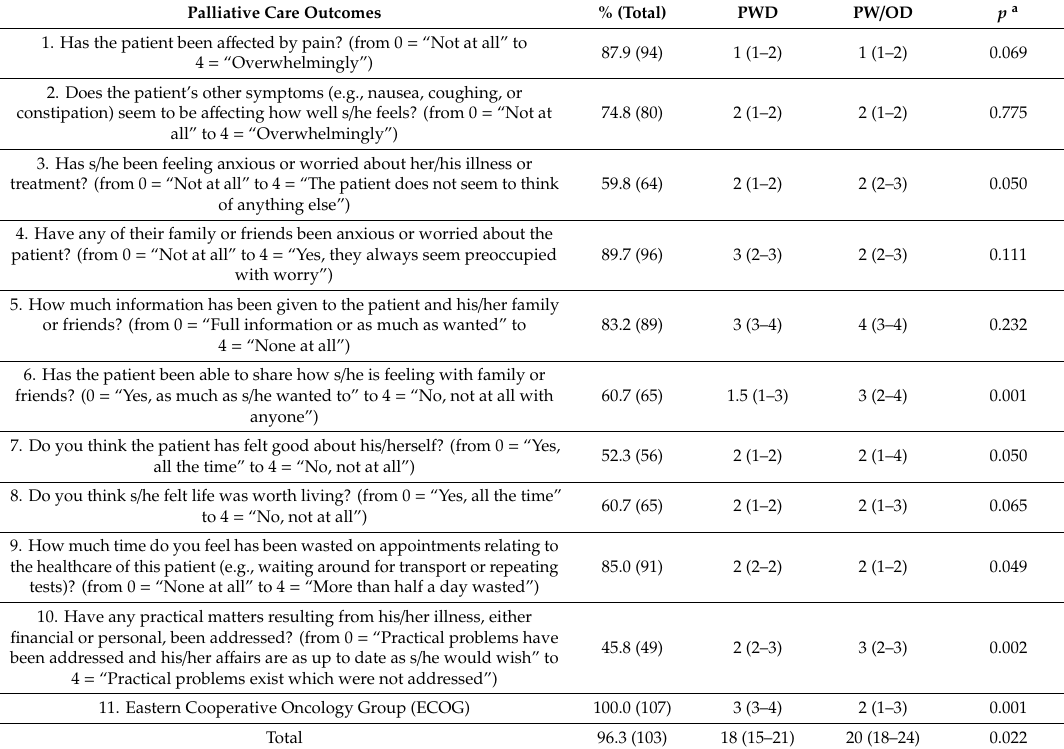
Table 3. Perception of palliative care outcomes reported by the Palliative Outcome Scale (POS) in patients of NH with dementia (PWD) and without dementia (PW /